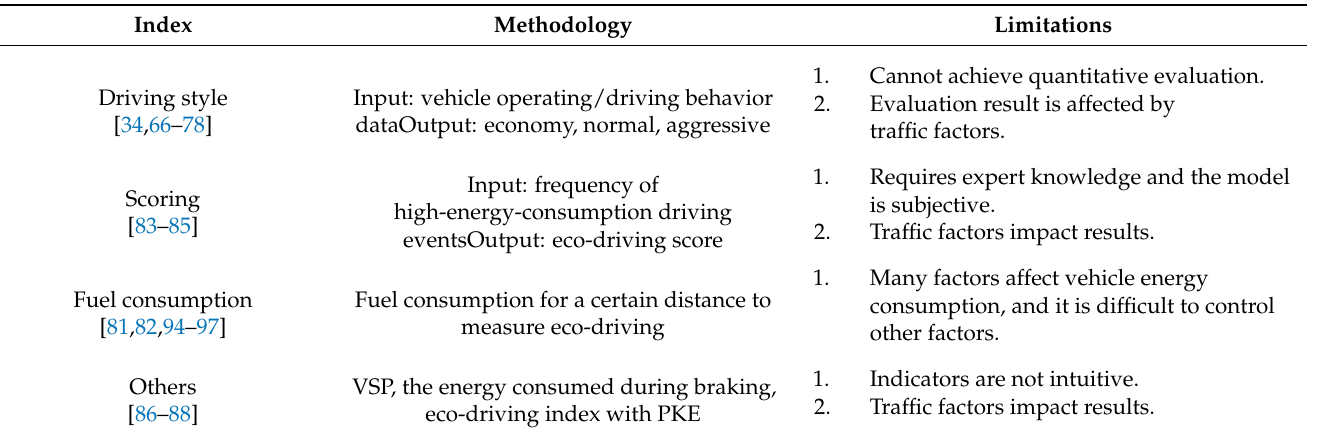
Table 1. Eco-driving evaluation methods and